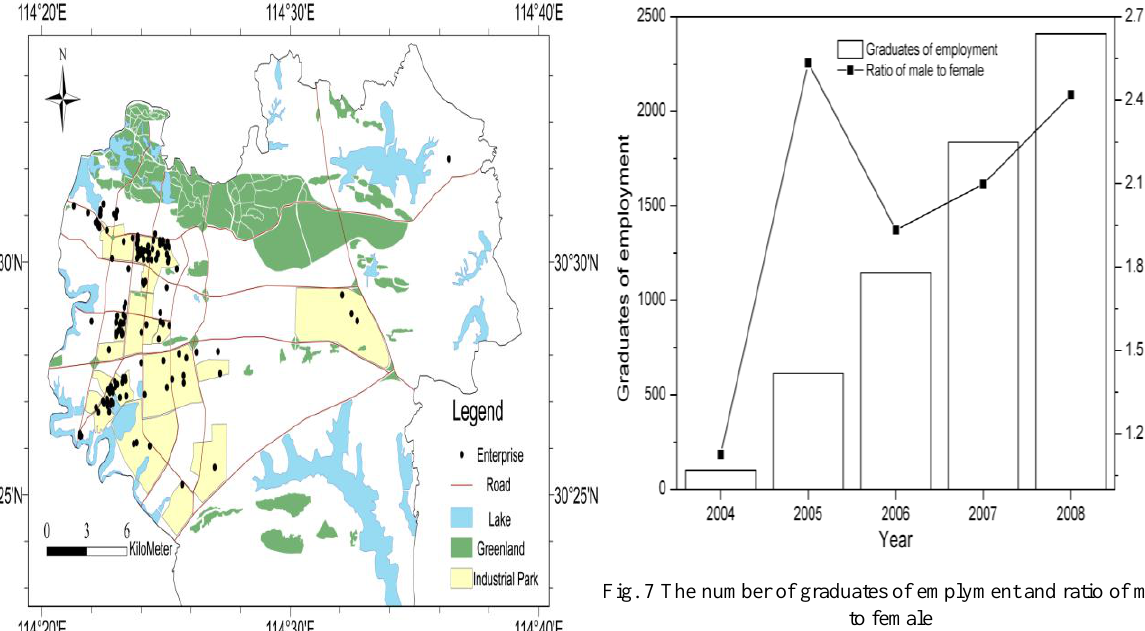
Fig. 5 Spatial distribution of enterprises in 2008